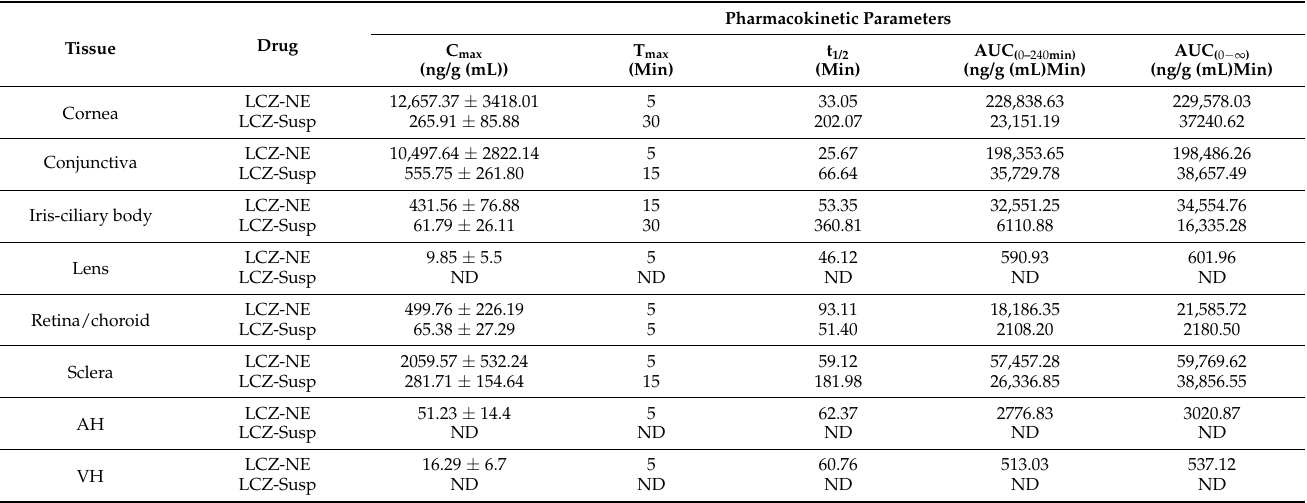
Table 5. Pharmacokinetic parameters of LCZ in rabbit eyes following one topical application of the LCZ-NE and